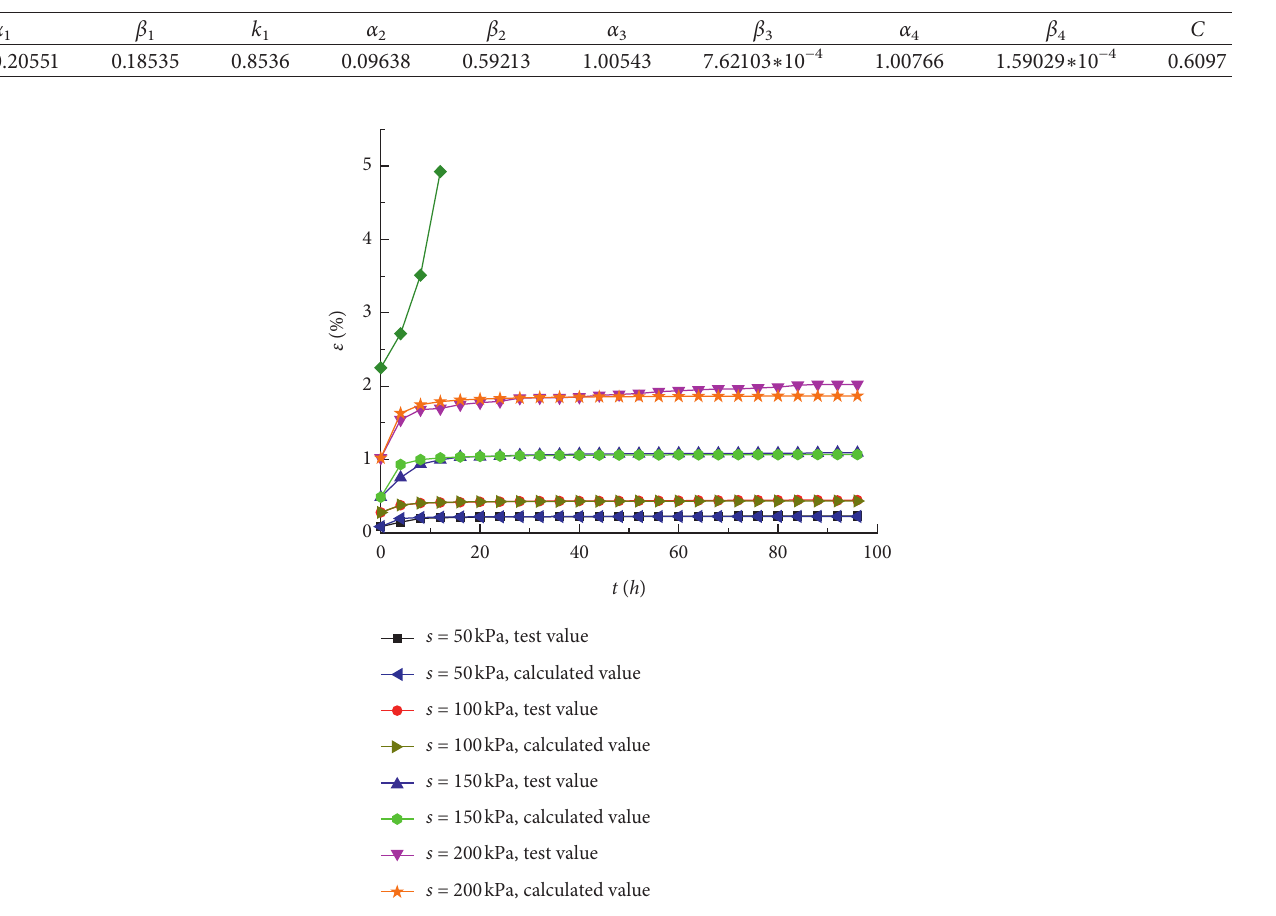
Figure 11: Relationship curves between parameters of a 2 and b 2 and initial static deviatoric stress. (a) a 2 and (b) b 2 . Table 10: Specific parameter values of equation (11).